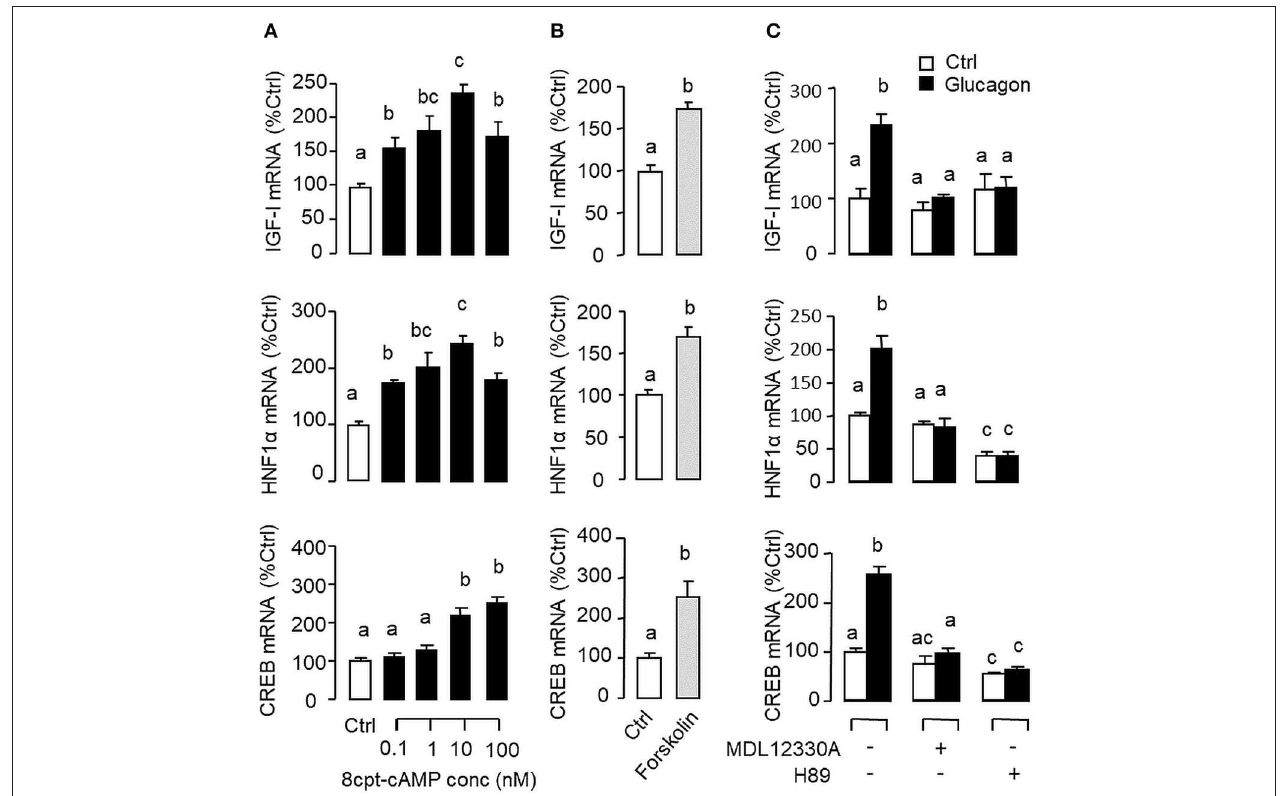
FIGURE 4 | Functional role of the AC/cAMP/PKA pathway in glucagon-induced IGF-I, HNF1 α , and CREB transcript expression at the hepatic level. Effects of (A) increasing functional levels of cAMP using the membrane-permeant cAMP analog 8cpt-cAMP (0.1–100nM) or (B) stimulating cAMP synthesis with the adenylate cyclase (AC) activator forskolin (1 µ M) on IGF-I, HNF1 α , and CREB mRNA expression in carp hepatocytes. In parallel study, glucagon induction (10nM) was also tested with co-treatment of the AC inhibitor MDL12330A (20 µ M) or PKA inactivator H89 (20 µ M) (C) . In these experiments, the duration of drug treatment was fixed at 12h. After that, total RNA was isolated from individual wells and used for real-time PCR with primers for IGF-I, HNF1 α , and CREB, respectively.